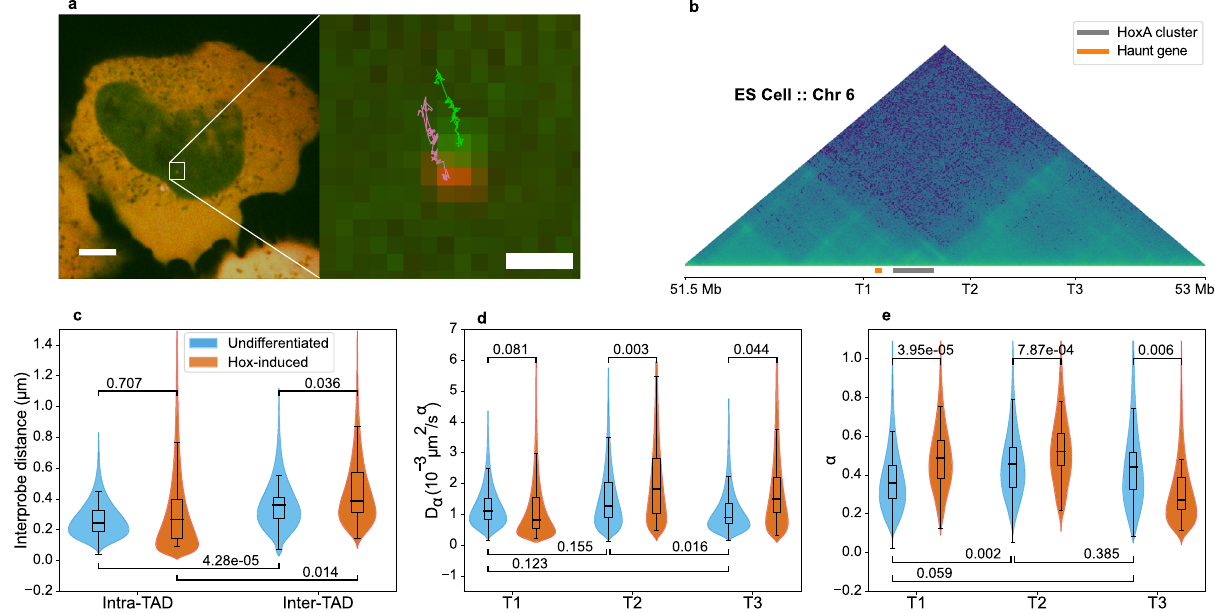
Fig. 4 Chromatin dynamics of three chromatin loci within the HoxA genomic region. a Example of microscopy image obtained for ANCHOR cell lines (scale 5 μ m) with tracked trajectories shown in ampli fi ed subpanel (scale 0.44 μ m). b ES Hi-C map around the HoxA cluster, illustrating the locus TAD structure. The positions of ANCHOR probes (T1, T2, and T3), the Haunt gene, and the HoxA cluster are shown underneath the map. c Inter-probe distances measured for ES cells before (blue) and after (red) treatment with retinoic acid. d , e Comparisons of apparent diffusion and anomalous coef fi cients between the three labeled loci, before (blue) and after (red) treatment with retinoic acid. Boxes represent the interquartile range and whiskers 95% of the data. Medians are shown as solid lines inside the boxes. A total of n = 56 and n = 67 spots were analyzed from the inter-TAD (T1-T2) cell line before and after treatment, respectively, from 3 independent experiments; n = 51 and n = 13 points were used for intra-TAD (T2-T3) cell line before and after differentiation, respectively, from 2 independent experiments. Source data are provided as a Source Data fi le.